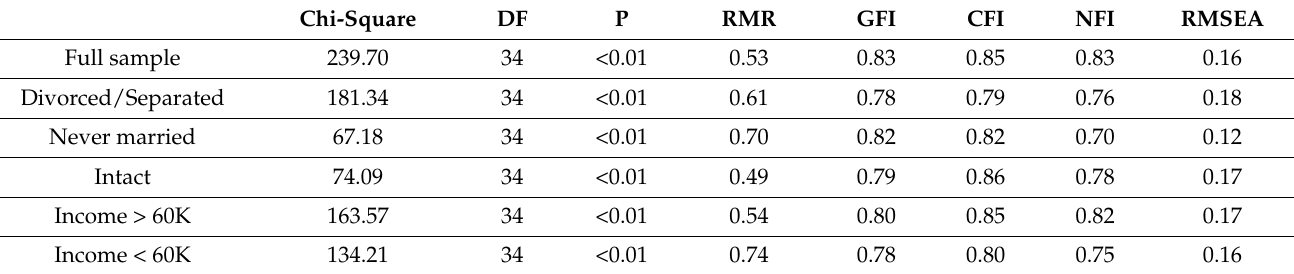
Table 3. CFA model fit indices for the 6 samples.